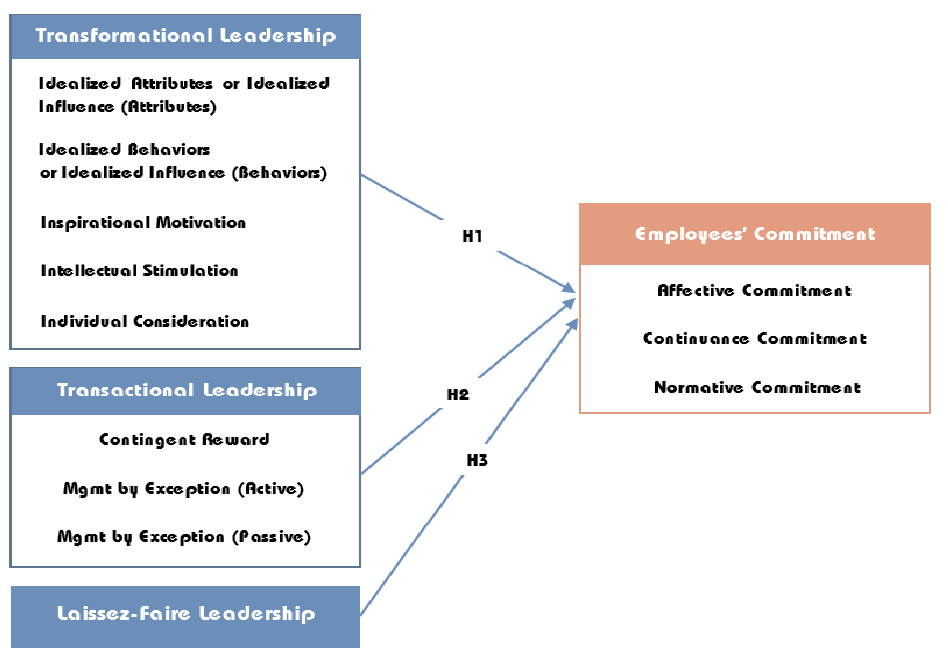
Figure 1. Conceptual